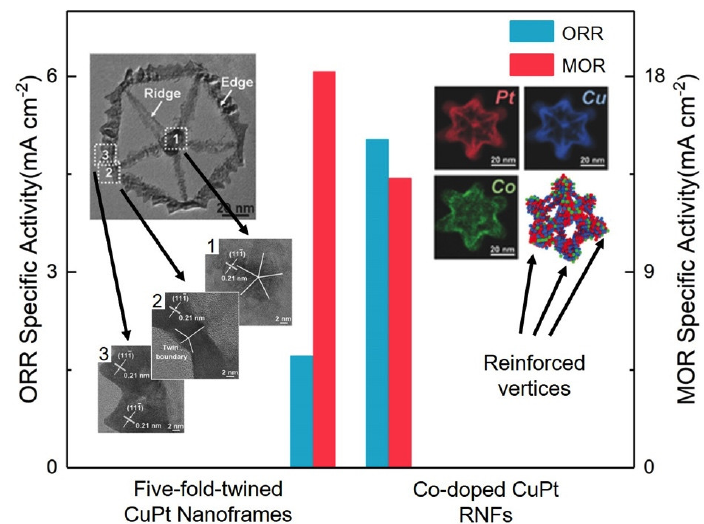
Figure 13. Comparison of two bifunctional Pt alloyed nanocatalysts: five-fold-twined CuPt nanoframes [109] and Co-doped CuPt rhombic dodecahedral nanoframes (RNFs) [110]. Inset on the left shows TEM image of five-fold-twined CuPt nanoframes with HRTEM images taken within dotted square 1, 2, and 3, which separately indicate five-fold twining, twining boundary, and protruding structure. Inset on the right shows atomic model of Co-doped CuPt (RNFs) and EDS mapping of a single nanoframe. Note the reinforced vertices as marked by black arrows. Inset images on the left were reprinted with permission from reference [109]. Copyright 2016 John Wiley and Sons. Inset images on the right were reprinted with permission from reference [110]. Copyright 2018 John Wiley and Sons.